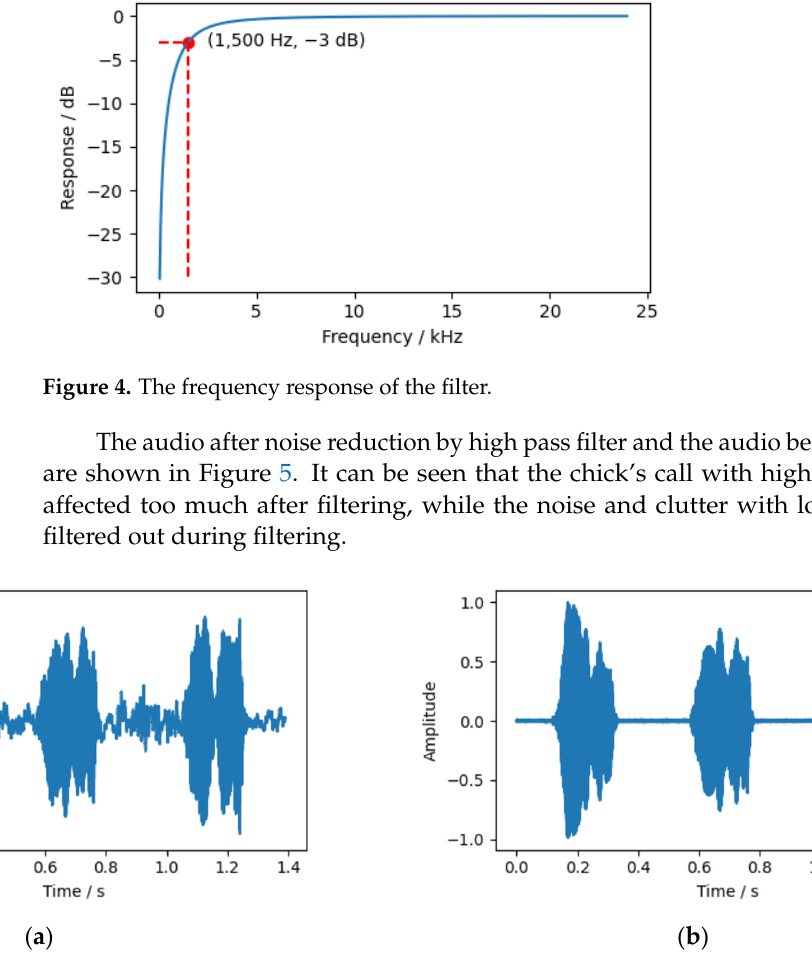
Figure 5. Audio waveform: ( a ) before filtering; and ( b ) after filtering.